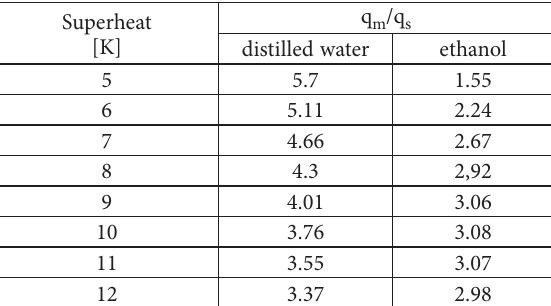
Table. Ratio of the heat flux for the surface with the mesh layer (q m ) and the smooth surface (q s ) – data from figure 4 Superheat